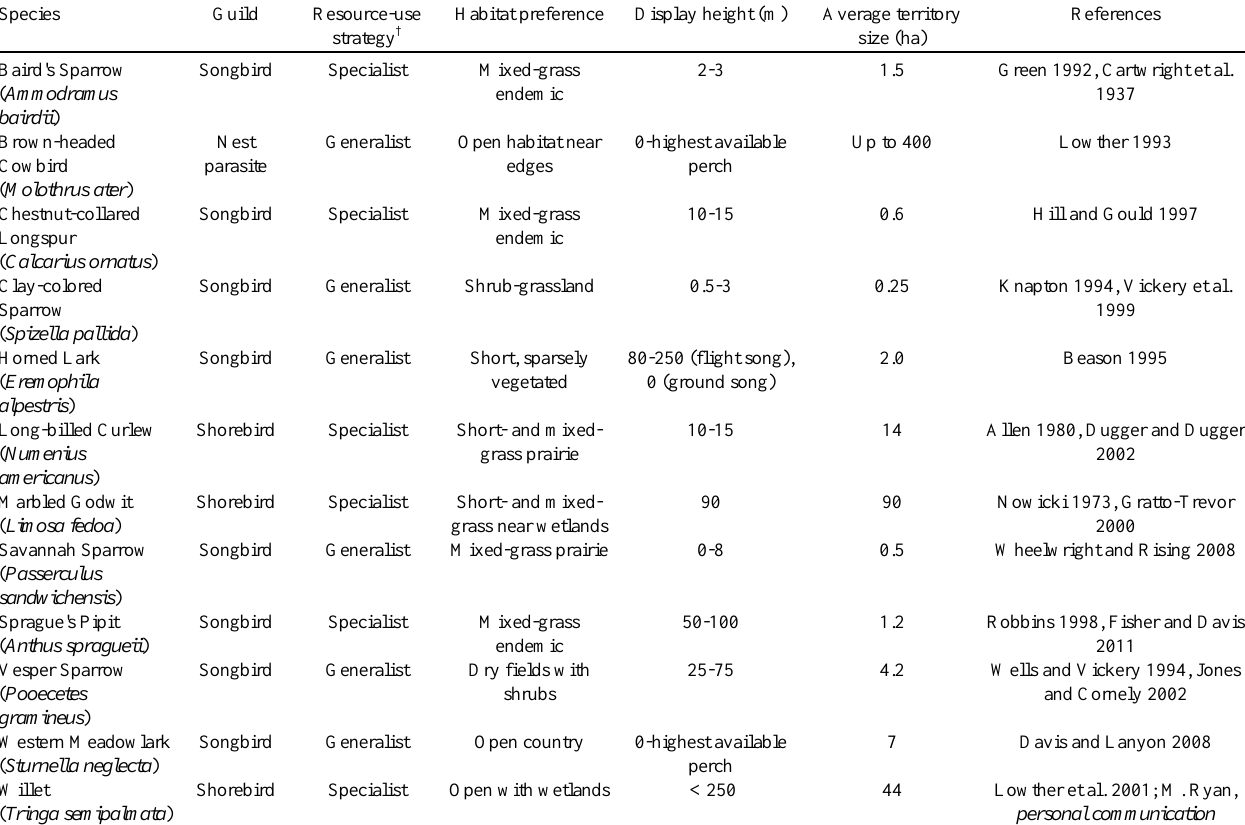
Table 1 . Summary of species characteristics of focal bird species used to evaluate edge